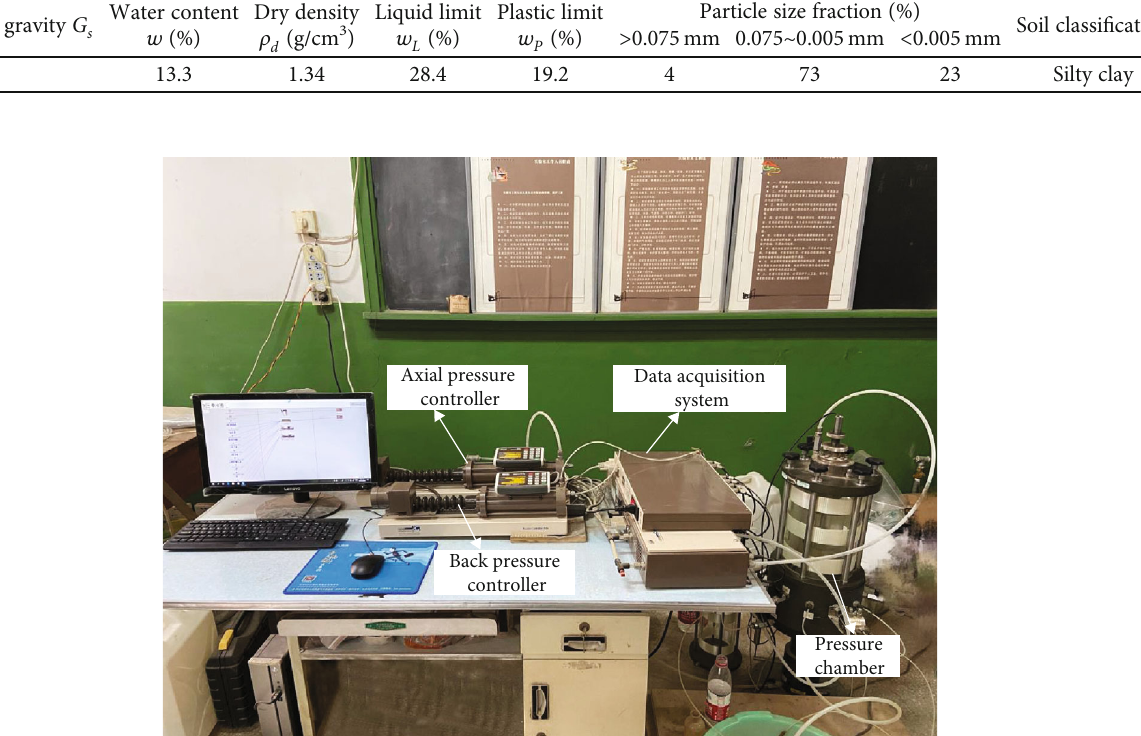
Figure 1: GDS triaxial